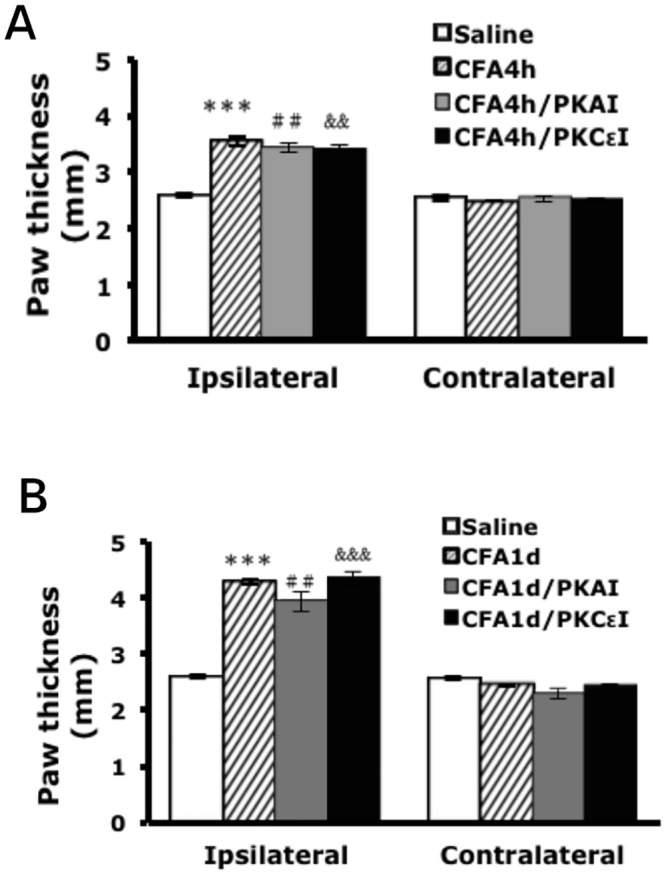
Thickness of mouse paw remains unchanged after blocking PKA or PKCε.Mice received intraplantar injection with 50μM of PKAI (H89) or PKCεI (TAT-PKCεV1-2) at 4 h or 1 day after 50% CFA injection. At 90 min after inhibitor injection, mice were killed and the thickness of injected (ipsilateral) and uninjected (contralateral) paws was measured. Data are presented as meanSEM of total tested mice (n = 3). Comparisons between CFA-injected (*), CFA/PKAI (#), or CFA/PKCεI (&) and saline-injected animals were analysed by one-way ANOVA with a post-hoc Bonferroni test. ##&&p<0.01, ***&&&p<0.001.